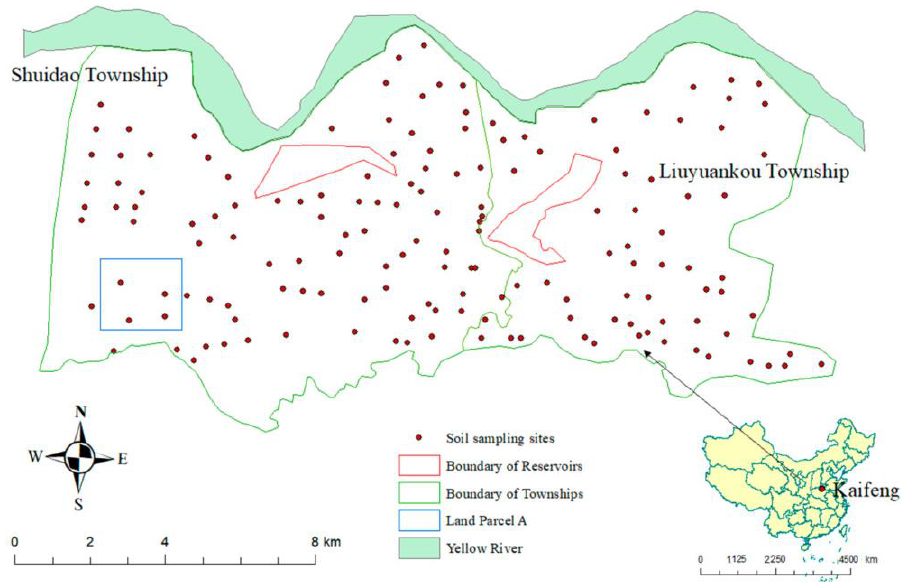
Figure 1. Soil sampling sites in the study